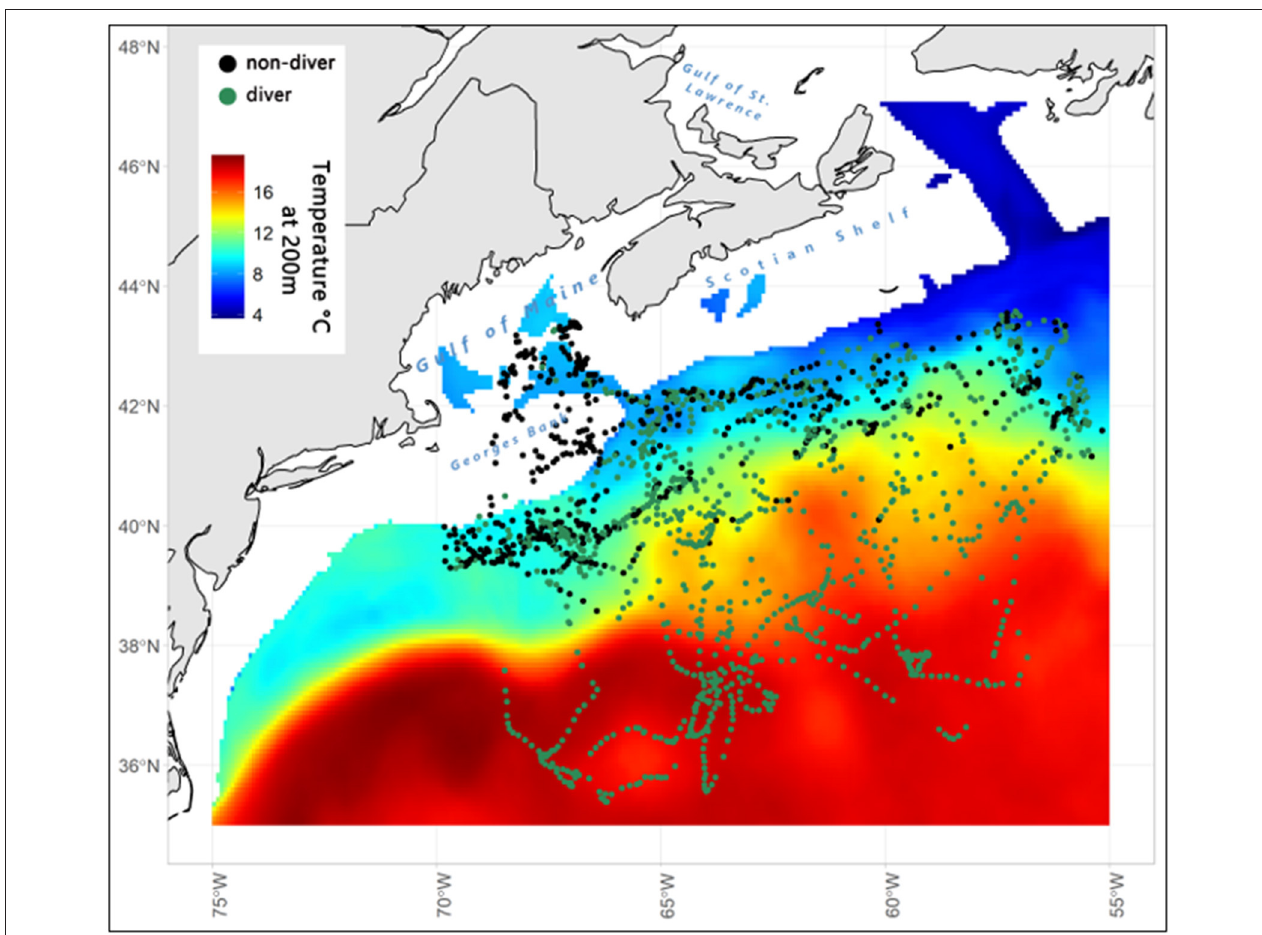
FIGURE 5 | Estimated geopositions for porbeagle divers and non-divers, overlaid on a composite of temperature ( ◦ C) at 200m (HYCOM, 0.08 ◦ resolution) for December 2006–March